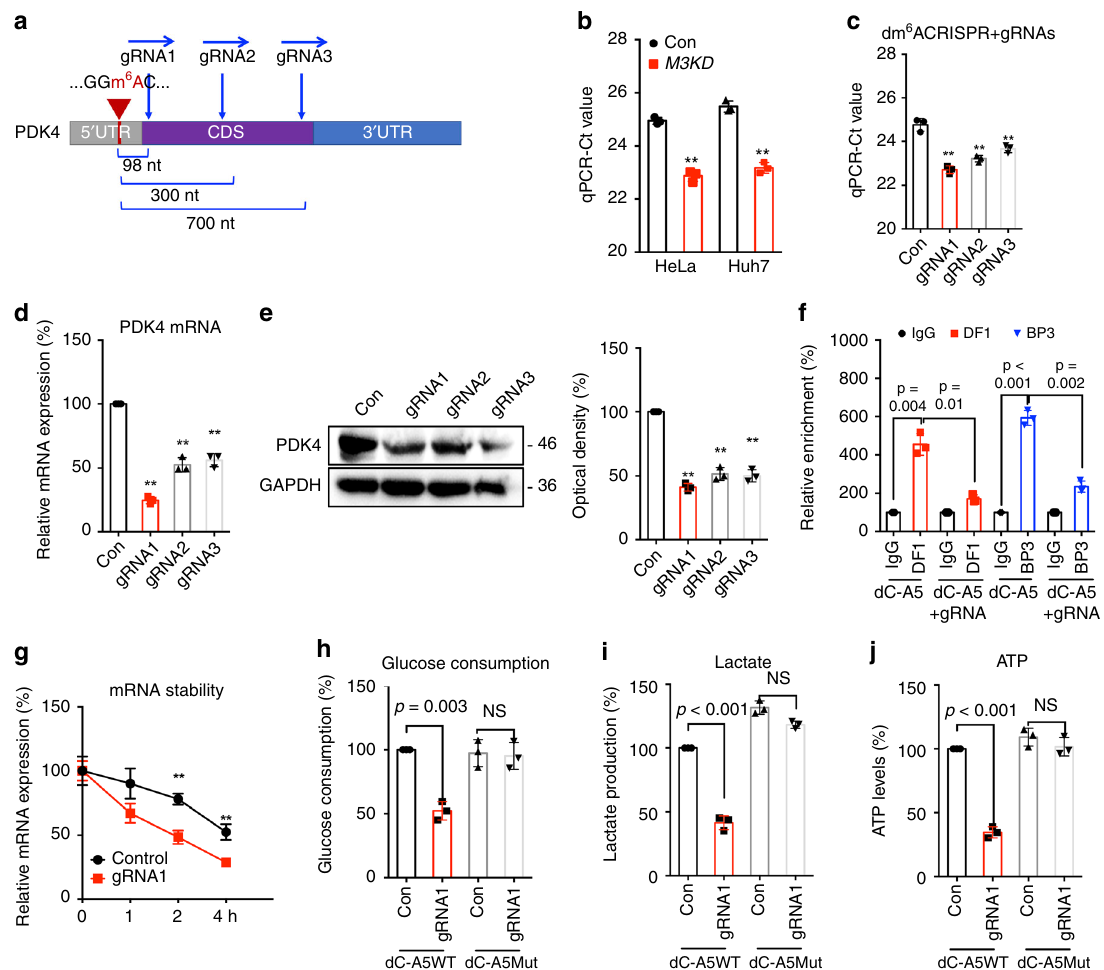
Fig. 6 Targeting m 6 A of PDK4 by dm 6 ACRISPR re-programs metabolic of cancer cells. a Schematic representation of positions of m 6 A site within PDK4 mRNA and the regions targeted by three gRNAs, respectively. b The threshold cycle (Ct) of qPCR showing SELECT results for detecting m 6 A site in the potential m 6 A site of PDK4 5 ′ UTR in Mettl3 Mut/- HeLa, sh-Mettl3 Huh7 and their corresponding control cells. c The threshold cycle (Ct) of qPCR showing SELECT results for detecting m 6 A site in 5 ′ UTR of PDK4 in HeLa cells transfected with dCas13b-ALKBH5 combined with gRNA control or gRNA1/2/3, respectively, for 24 h. d , e The mRNA ( d ) or protein ( e ) expression of PDK4 in HeLa cells transfected with dCas13b-ALKBH5 combined with gRNA control or gRNA1/2/3, respectively, for 24 h. f RIP-qPCR analysis of PDK4 mRNA in HeLa cells transfected with dCas13b-ALKBH5 combined with gRNA control (dC-A5) or gRNA for PDK4 (dC-A5 + gRNA) for 24 h by use of antibodies against YTHDF1 and IGF2BP3, respectively. g HeLa cells were transfected with gRNA control, gRNA1 for PDK4, and dCas13b-ALKBH5 for 24 h and then further treated with Act-D for the indicated times. The mRNA of PDK4 was checked by qRT-PCR. h – j The glucose consumption ( h ), lactate production ( i ), and ATP levels ( j ) in HeLa cells transfected with gRNA control, gRNA1 for PDK4 , and dCas13b-ALKBH5 or dCas13b-ALKBH5-Mut for 24 h. Data are presented as means ± SD from three independent experiments. ** p < 0.01, NS, no signi fi cant, by two-tailed unpaired Student ’ s t test for ( b ) ( p = 0.001 and p = 0.002, respectively), ( h – j ) one-way ANOVA for ( c ) ( p < 0.001), ( d ) ( p < 0.001), and ( e ) ( p < 0.001), and two-way ANOVA for ( f ) and ( j ) ( p <